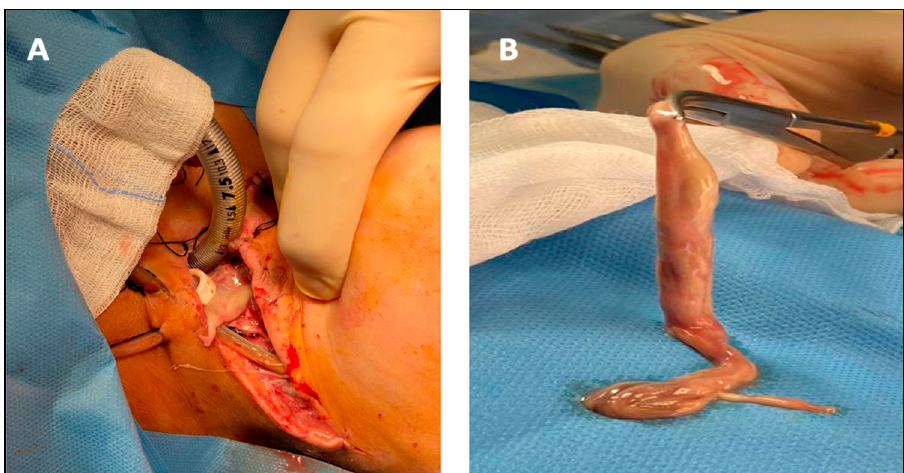
Figure 2. The wall of the abscess in the neck during the surgical drain ( A ) and after the removal ( B ). Once the membrane was removed, the thoracic surgeon performed an exploration of the anterior mediastinum, which confirmed the patient was free from further infected material. Then, a Penrose drain was positioned in the oral cavity, one Redon drain in the submandibular lodge, one in the laterocervical space and another one in the upper anterior mediastinum. At the end, the ENT surgeon performed a tracheostomy to protect the airways.